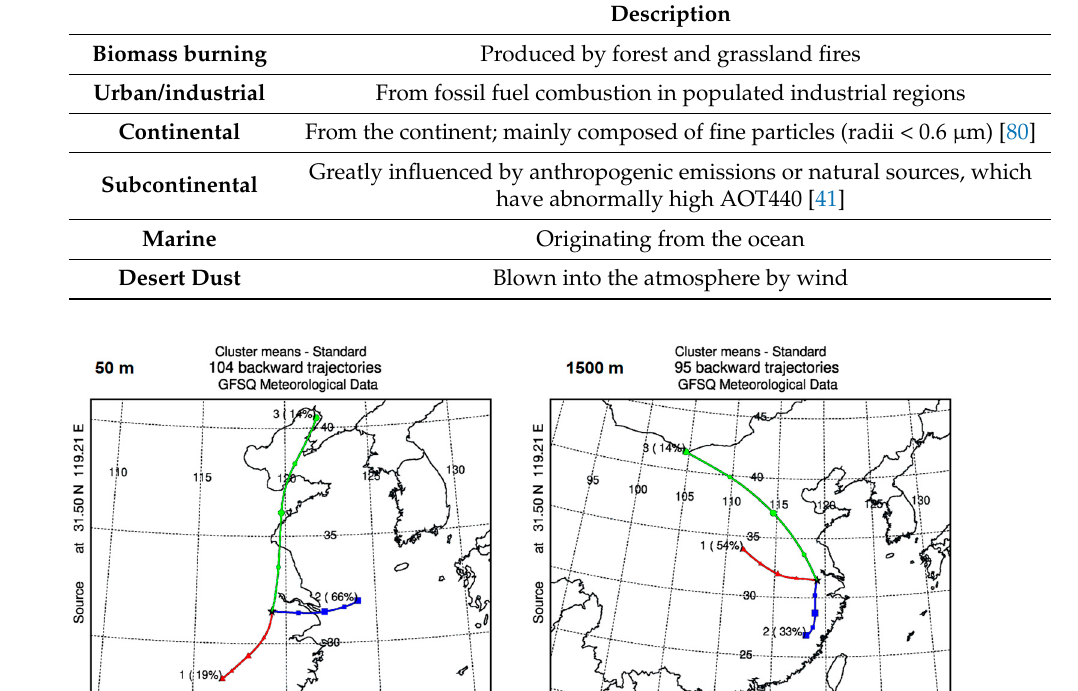
Table A2. Definition of key aerosol types (reference: Dubovik et al., 2002 [42]).